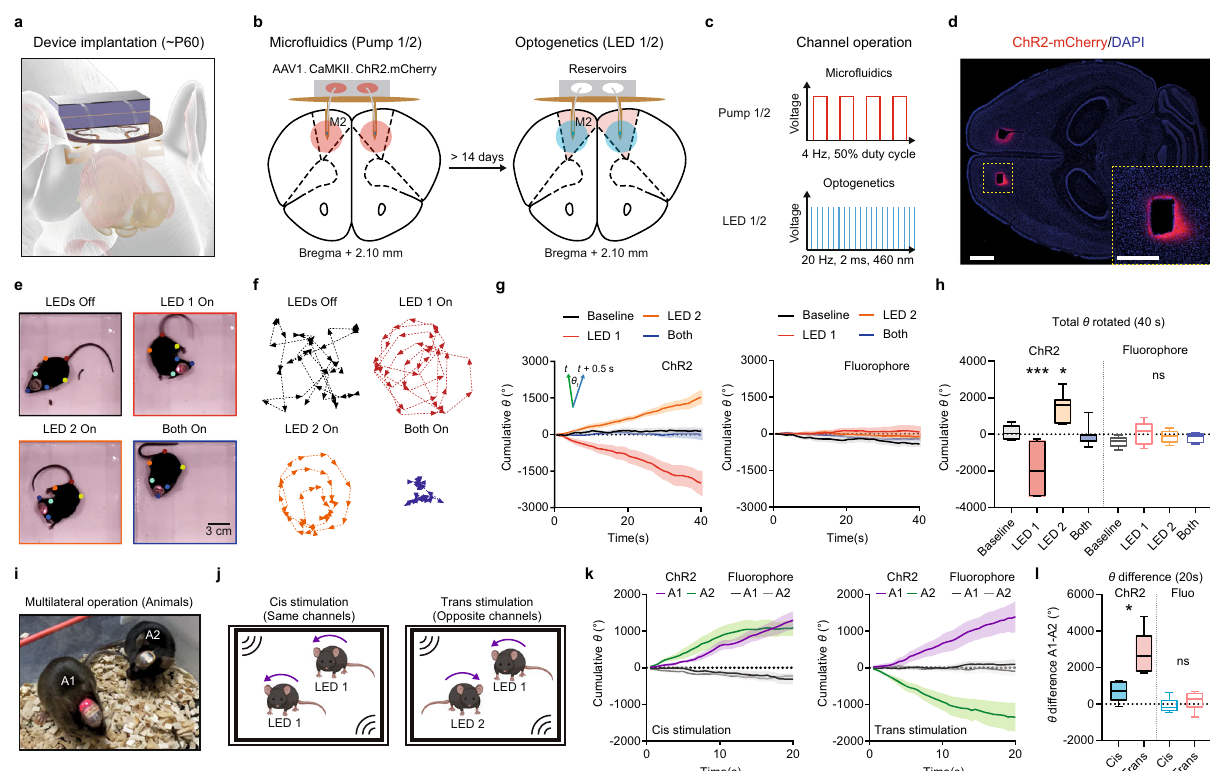
Fig.4|Optogeneticcontrolofmotorbehaviorofindividualandgroupedmice using multilateral opto fl uidics device. a Schematic illustration of device implantation on the skull of a mouse model. b Schematic illustration of virus transduction and experimentaltimeline. c Parametersofmicro fl uidicdeliveryand optogenetic stimulation for individual channels. d Example image of ChR2- mCherry expression in M2 after virus transduction using micro fl uidic channels. Scale bar: 1mm and 500 µ m. e Example frames of one ChR2-expressing mouse during controlled optogenetic stimulation using different channel operations. f Example traces of one ChR2-expressing mouse in a 20-second-long episode with different channel operations. g Left, summary data showing the cumulative rota- tion degrees in mice expressing ChR2 during a 40-second-long episode. Right, same as left, but for mice expressing control fl uorophore. Inset, calculation of rotation degree ( θ ) for each frame (0.5s bin). n =7 animals/group. Data are pre- sentedasmeanvalues±SEM. h Summarydatashowingthetotaldegreesrotatedin eachexperimentalcondition.One-wayANOVA,ChR2, p <0.0001, F(3,24)=20.16; Fluorophore, p =0.1858, F (3, 24)=1.739. Sidak ’ s multiple comparison, ChR2 (vs